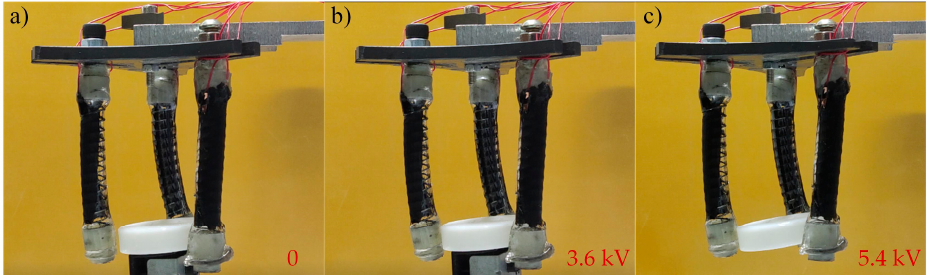
Figure 14. Grasping process of the soft gripper. ( a ) The condition when the voltage is 0; ( b ) The grasping condition when the voltage is 3.6 kV; ( c ) The final result of the grasping when the voltage is 5.4 kV.